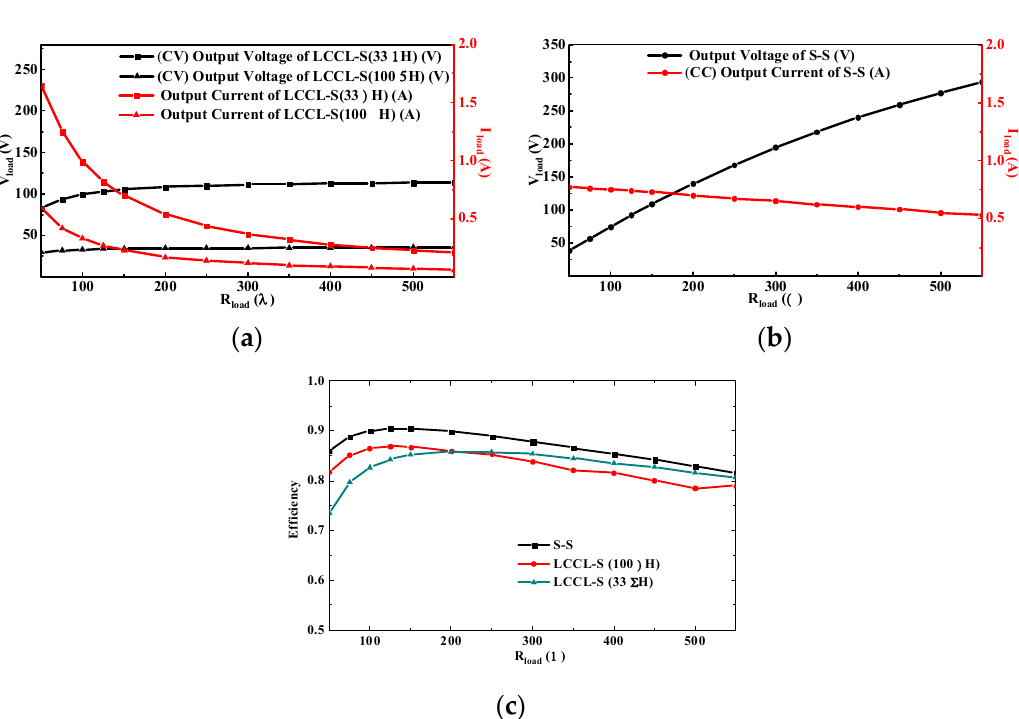
Figure 6. FBI output current/voltage waveformes and ZVS condition of ( a , d ) LCCL-S with L 1 = 33 μ H, ( b , e ) LCCL-S with L 1 = 100 μ H, and ( c , f ) S-S.